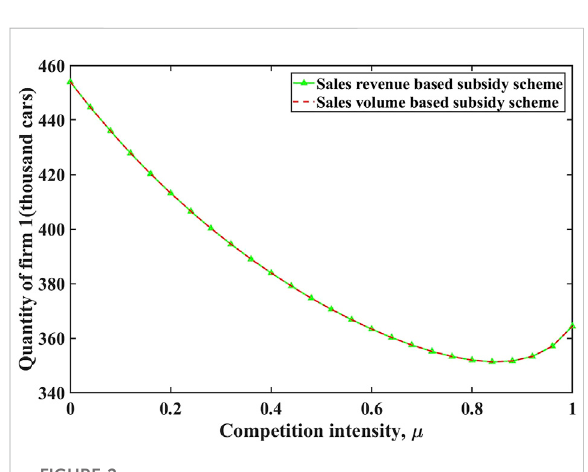
FIGURE 2 Comparison of fi rm 1 ’ s quantity under two different subsidy schemes.